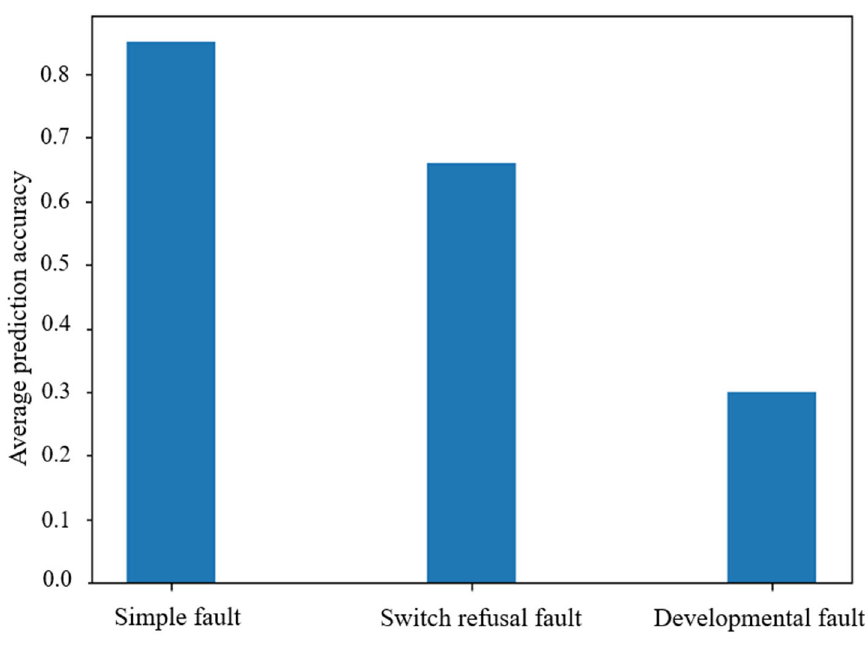
Figure 7. Average prediction accuracy.